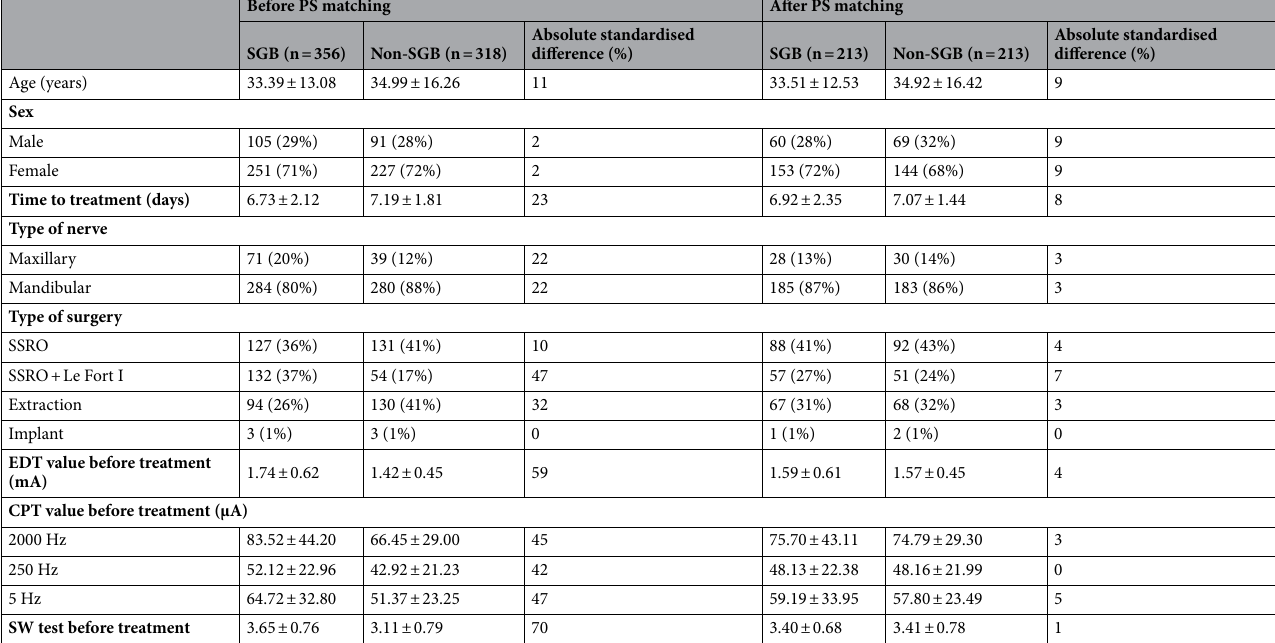
Table 1. Patient characteristics before treatment. Data are presented as number of patients (percentage) or mean ± standard deviation. PS propensity score, SGB stellate ganglion block, SSRO sagittal split ramus